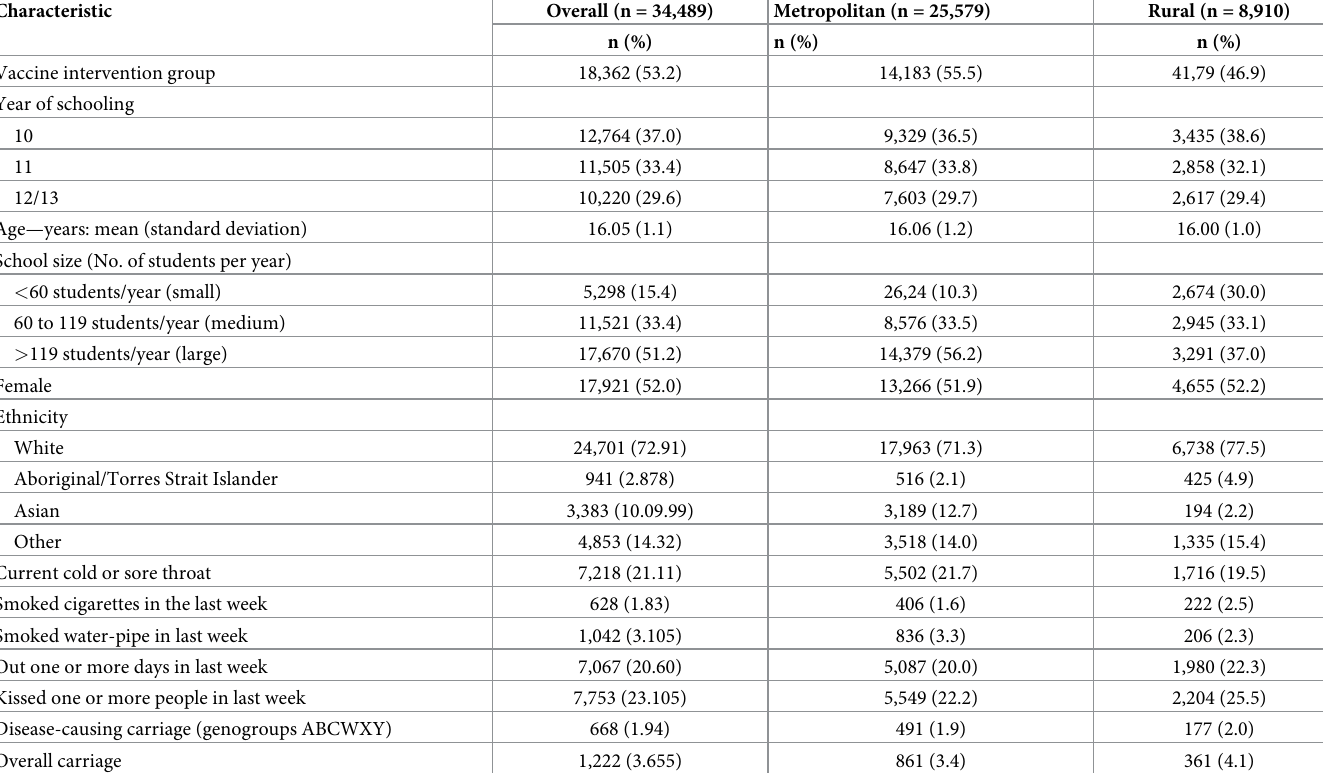
Table 1. Baseline characteristics of participants (school years 10 to 12) in a cluster randomized controlled trial to assess oropharyngeal carriage of Neisseria menin- gitidis by location in South Australia in